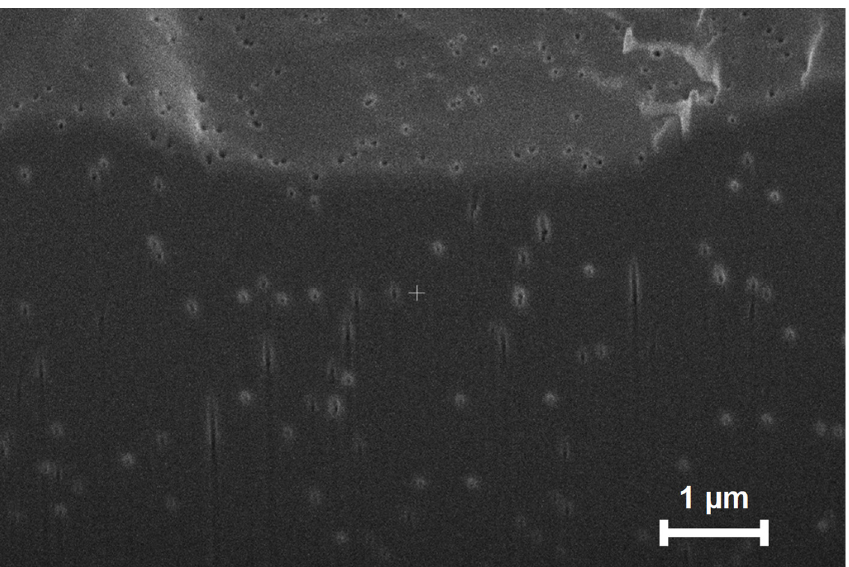
Figure 5. Cross-sectional SEM image of a polycarbonate track-etched membrane with 30 nm pores. The dark region is the cross section, whereas the brighter section at the top is the membrane surface. A focused ion beam was used to section the membrane sample in the middle prior to SEM imaging of the membrane cross section (Helios G4 Ux Dual Beam instrument). Prior to imaging, the membrane was coated with a layer of Palladium. Some pores show their tracks passing through the membrane, but most pores only show an entrance in the cross-section, and this indicates that pores have different orientations and different pore